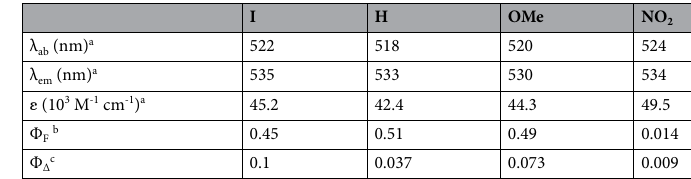
Table 1. The photophysical and photosensitizing properties of BODIPY I , H , OMe , and NO2 in MeOH. a Absorption and fluorescence data measured using methanol. b Fluorescence quantum yields were determined using rhodamine 6G in methanol as the standard (Φ f = 0.94) 42 . c Singlet oxygen quantum yields were determined by the DPBF bleaching method, using HP in ethanol as a reference (Φ Δ = 0.53) 43 .